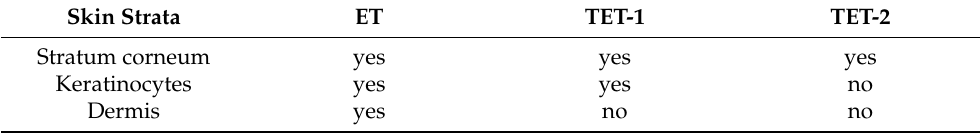
Table 3. Distribution of vesicular nanosystems through the skin, as determined ex vivo by TEM. Skin Strata ET TET-1 TET-2 Stratum corneum yes yes yes Keratinocytes yes yes